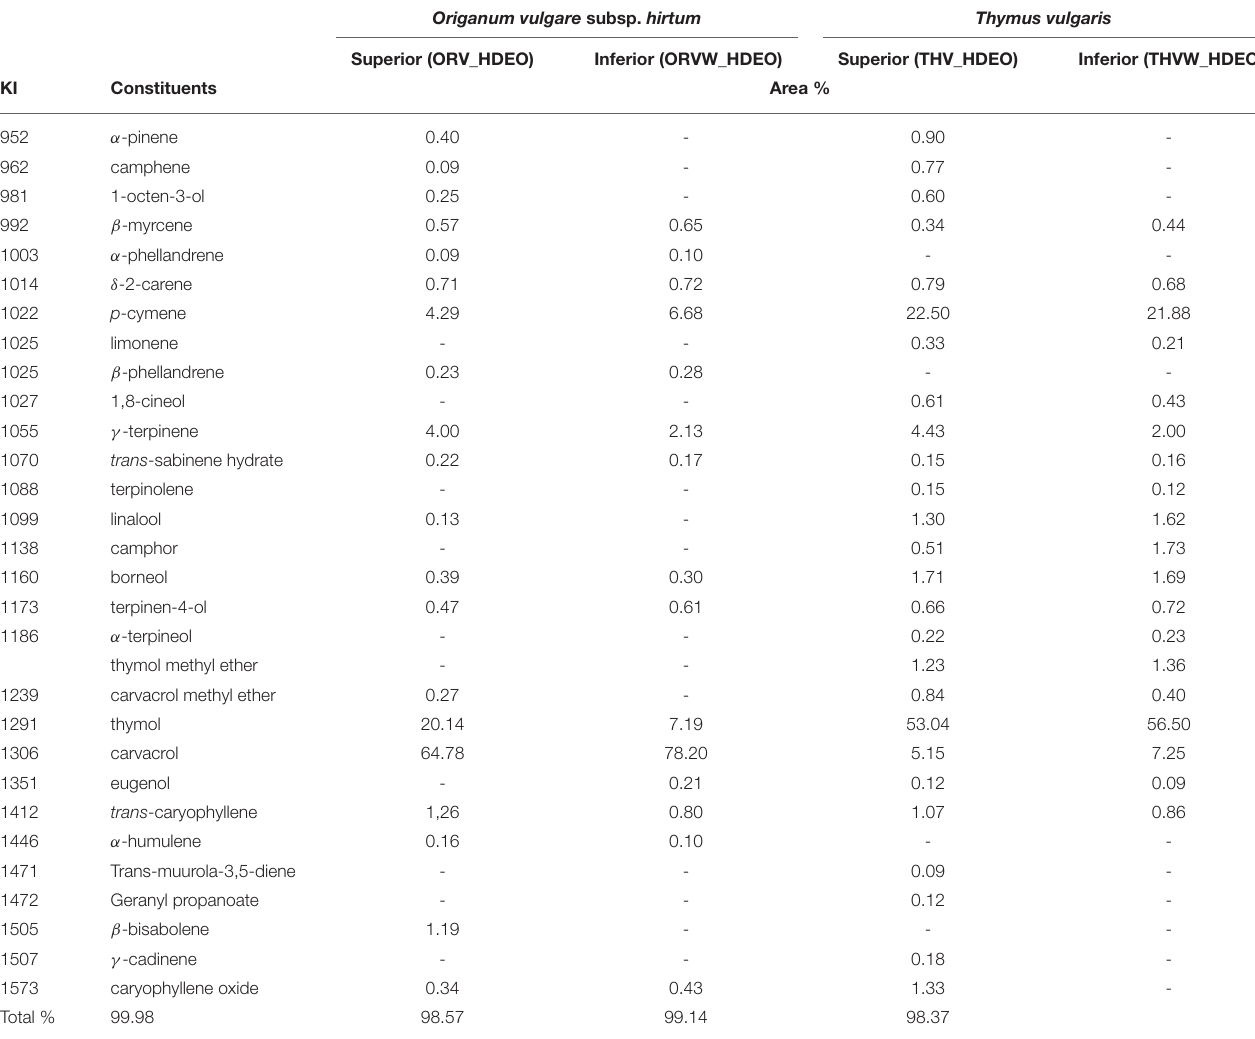
TABLE 6 | Chemical composition of the essential oils (EOs) of superior and inferior plant material of T. vulgaris (thyme) and O. vulgare subsp. hirtum (oregano). Origanum vulgare subsp. hirtum